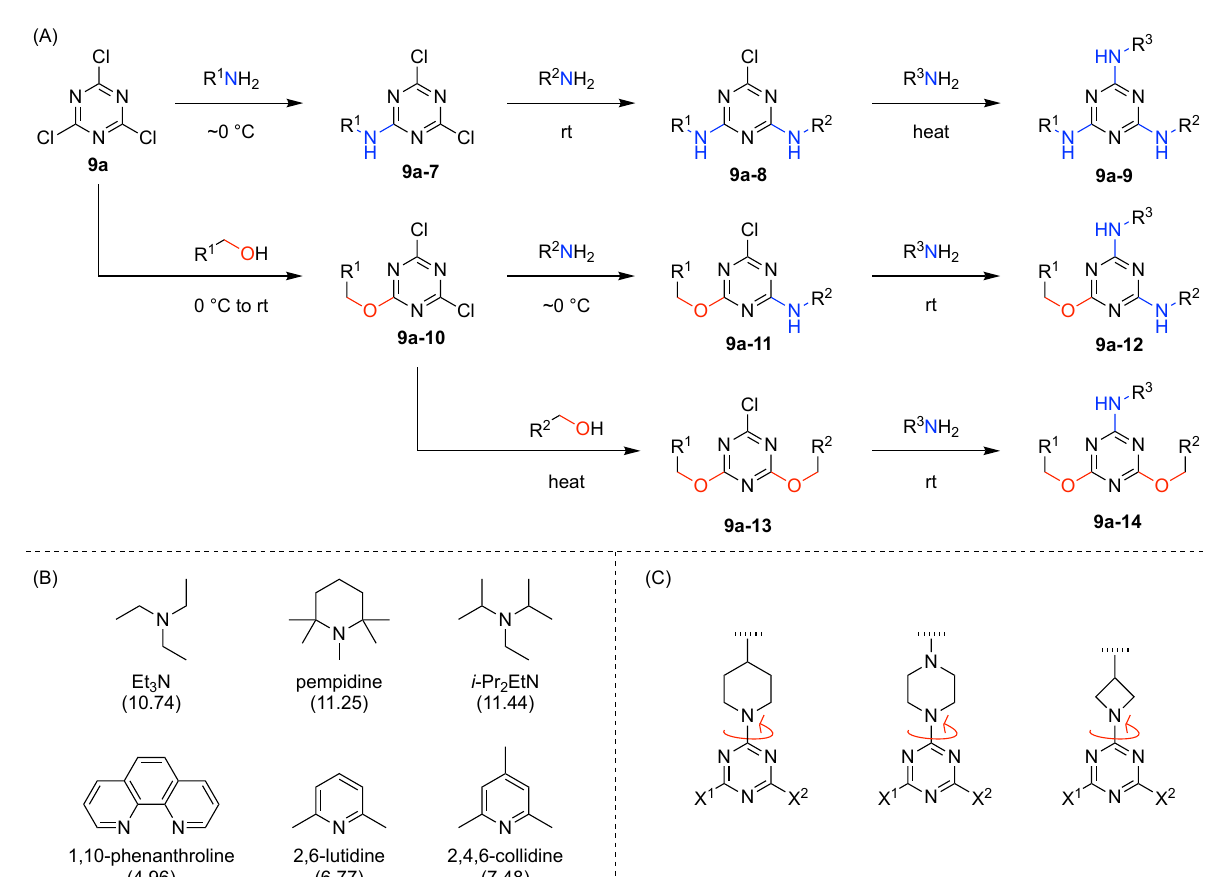
Figure 35. ( A ) Synthesis of triazine hubs bearing amino or alkoxy groups: (top) triaminotriazine, (middle) alkoxydi- aminotriazine, and (bottom) dialkoxyaminotriazine; ( B ) amine bases employed in chlorotriazine substitution with amines and alcohols. The p K a values (in H 2 O) are shown in parentheses; and ( C ) dialkylamino substituents avoiding formation of rotamers.